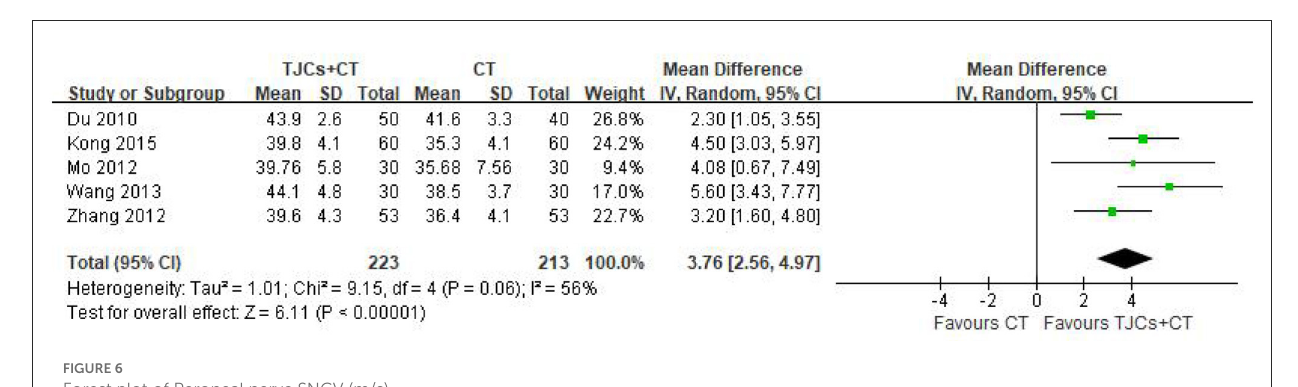
FIGURE6 Forest plot of Peroneal nerve SNCV